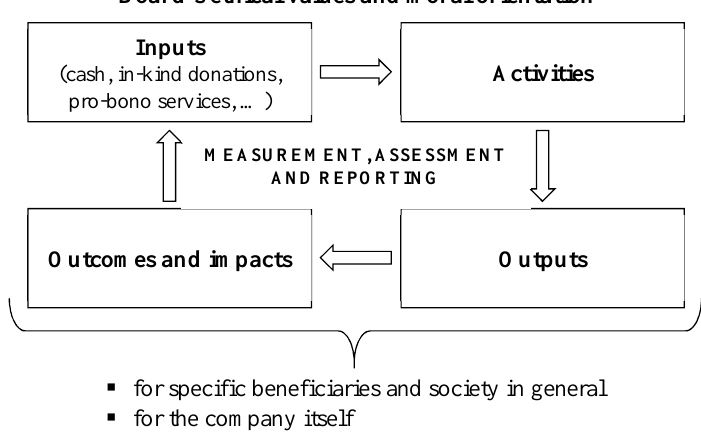
Figure 2: Strategic Approach to Corporate Community